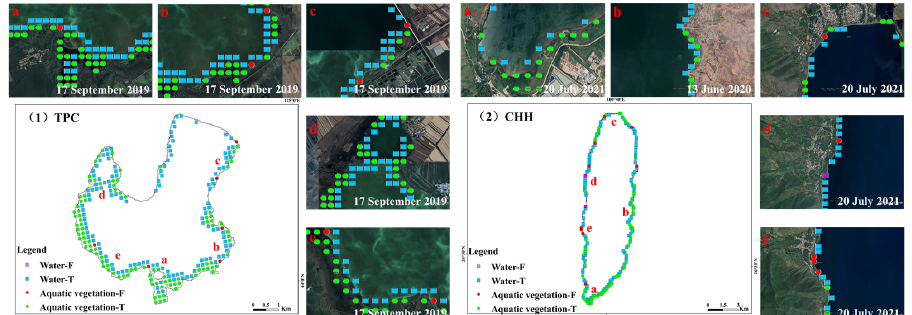
Figure 11. Distribution of validation points and validation results in nonmodeled Lakes, ( 1 ) TCP— Taipingchi Reservoir, ( 2 ) CHH—Lake Chenghai. Five points have been selected in different areas of each lake and their positions in the lake are marked by the letters a – e . The corresponding Google Maps images used for the verification and the results of the verification are shown in the five subimages ( a – e ). The date of the image used for verification can be seen in the bottom right corner of each subimages. Aquatic vegetation ‐ T/F are points within the range of aquatic vegetation. Water ‐ T/F are points within the buffer zone outside the range of aquatic vegetation. T is the point verified as correct. F is points verified as incorrect.